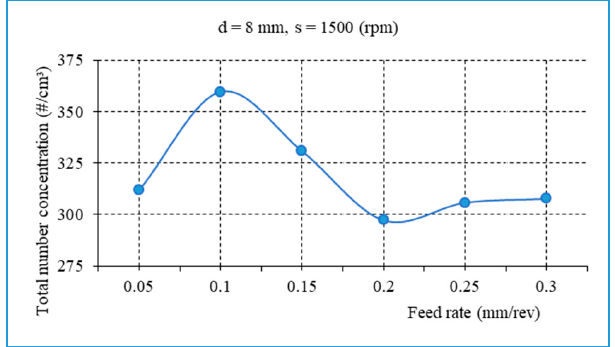
Materials 2020 , 13 , x FOR PEER REVIEW Figure 20. The fine particles related to the feed rate, with d = 8 mm, s = 1500 rpm.